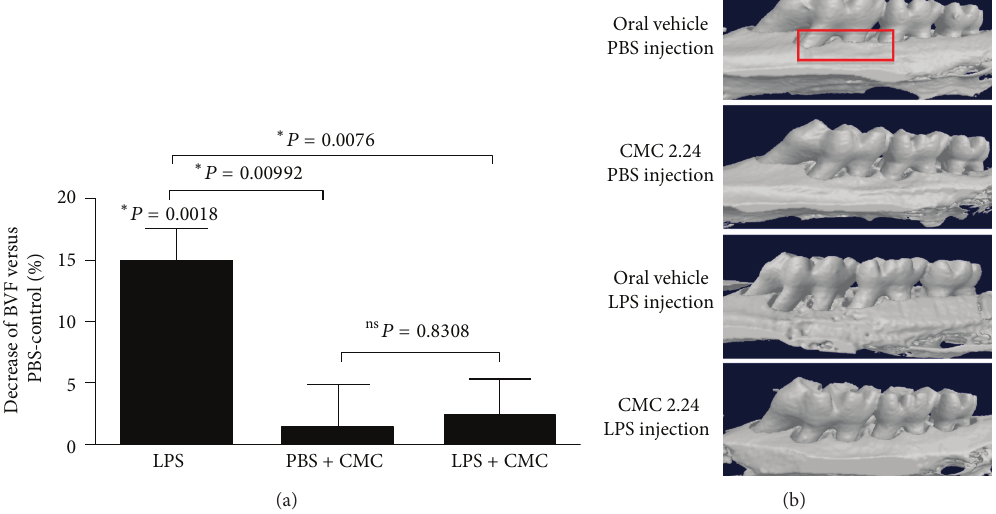
Figure4: 𝜇 -CTdataconfirmingthatCMC2.24significantlyinhibitsalveolarboneresorptionintheinvivomodelofLPS-inducedperiodontal disease. Rats received either 2% carboxymethylcellulose vehicle or 30mg/Kg of CMC 2.24 by oral intubation daily for 2 weeks. Contralateral LPS(3 𝜇 L,30 𝜇 g)orPBS(3 𝜇 L)vehicleinjectionswereperformed3times/weekfor14daysatthepalatalaspectoffirstmolars(seeFigure 1).The